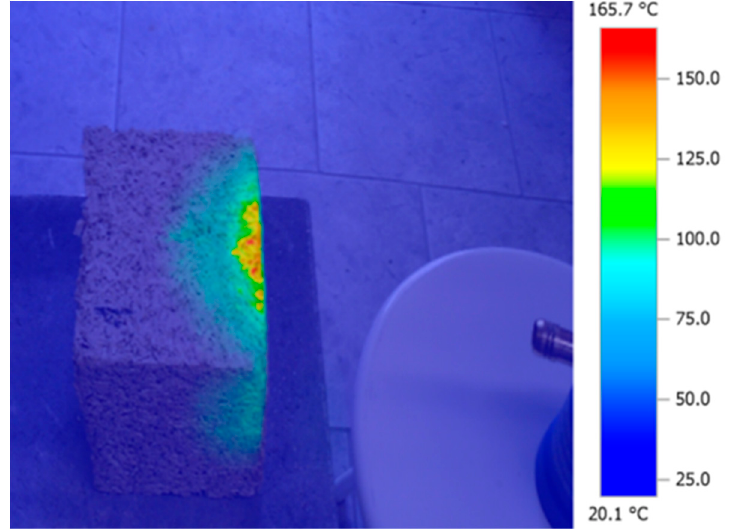
Figure 6. Sample thermal distribution following the flame test.